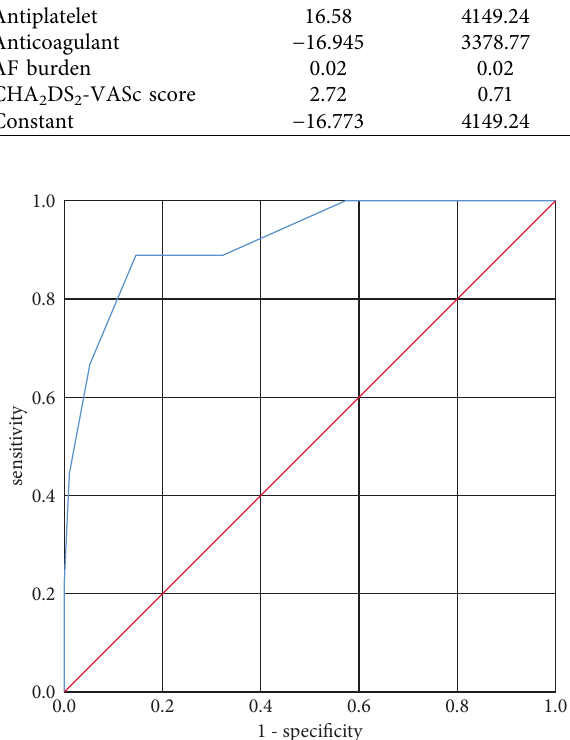
Figure 1: ROC curve of CHA 2 DS 2 -VASc score for stroke